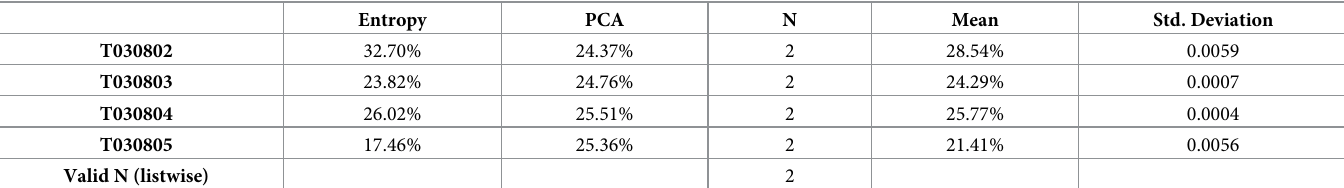
Table 6. Descriptive on standard deviation to Case Study 1.